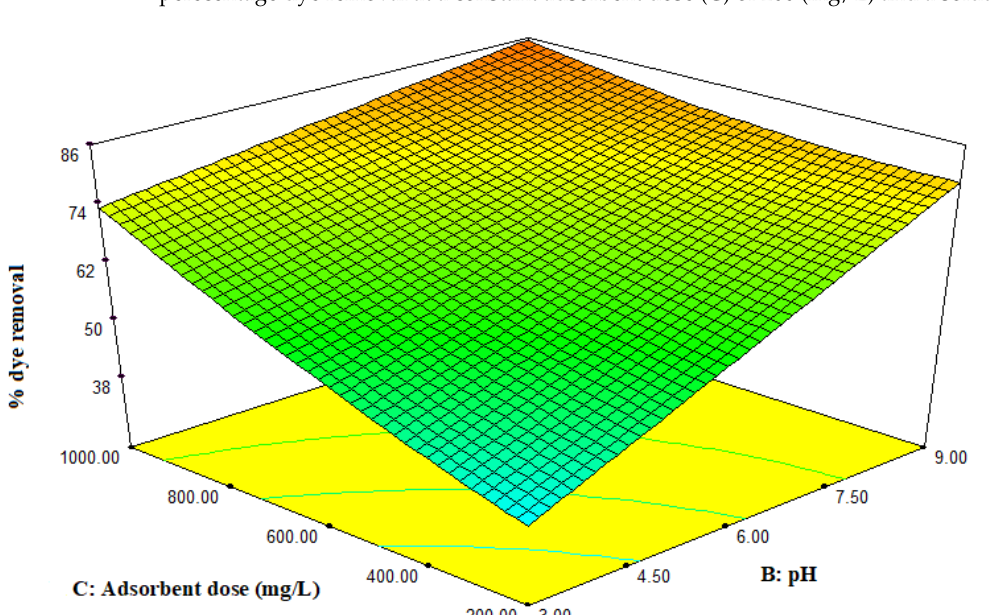
Figure 13. Interaction effect between the contact time (D) and initial dye concentration (A) on the perecentage dye removal at a constant adsorbent dose (C) of 200 (mg/L) and a solution pH (B) of 9.